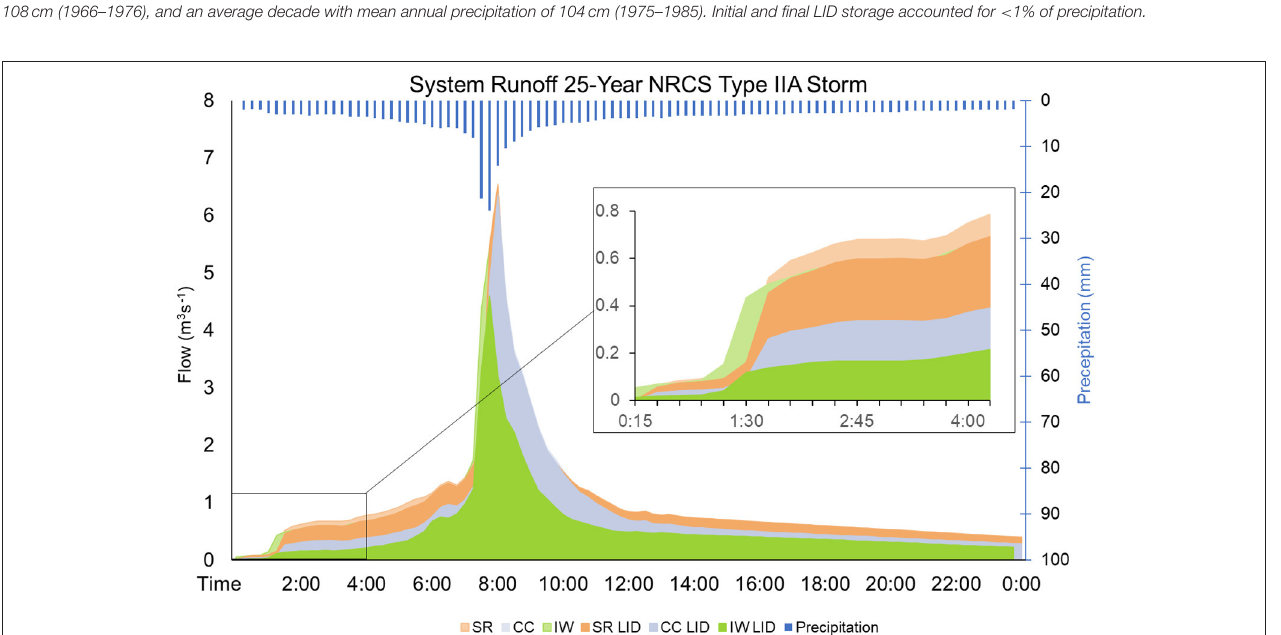
between 71 and 82 cm yr − 1 . Infiltration loss in the IW